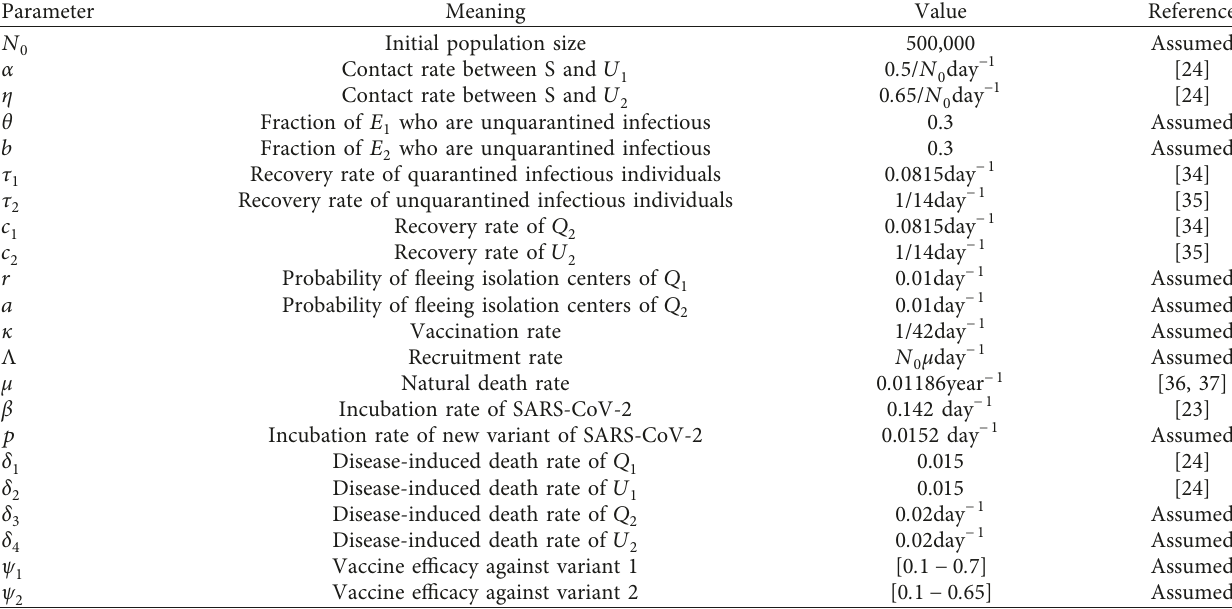
Table 1: Summary of the